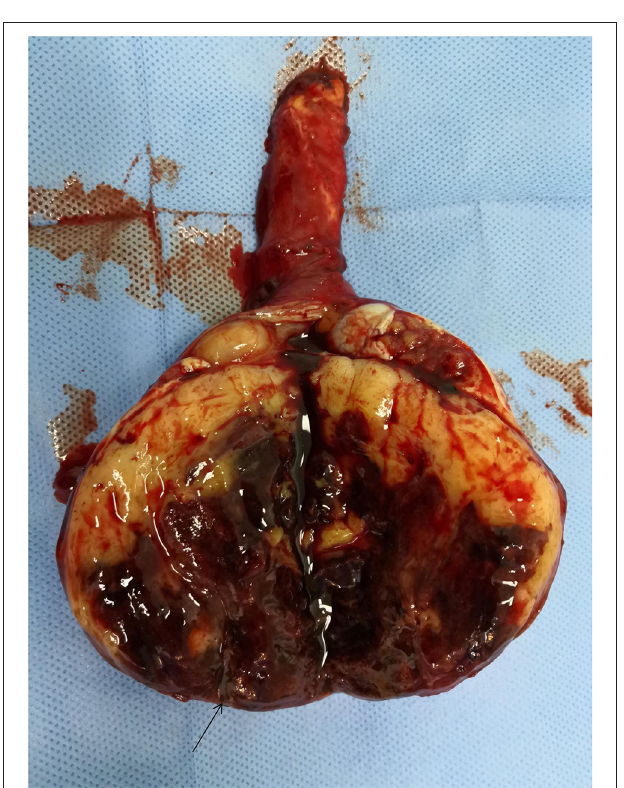
FIGURE 4 | Surgical specimen: the rupture of testicular tunica albuginea.